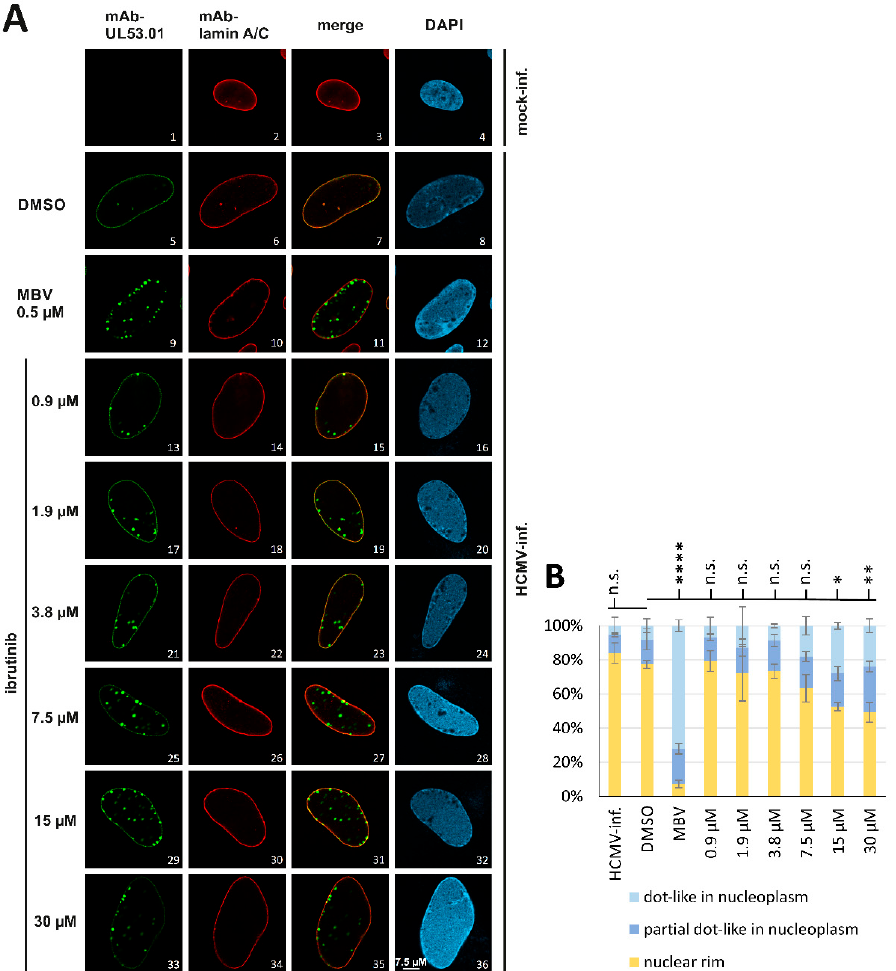
Figure 11. Inhibitory impact of hit compound ibrutinib on the localization of HCMV pUL53. ( A ) HFFs were infected with HCMV AD169 (MOI 0.1) and immediately treated with the warhead compound. Ibrutinib was applied at the indicated concentrations, and the determination was performed in biological triplicates. At 5 d p.i., cells were fi xed, used for IF staining with the indicated antibodies and analyzed for intranuclear localization by confocal imaging. DAPI counterstaining represented the nuclear morphologies of the respective cells. Additional single channel images in grayscale, allowing easier comparison of signal pa tt erns, are presented in Figure S5. For raw data, see h tt ps://doi.org/10.5281/zenodo.7794233 accessed on 3 April 2023. ( B ) Quantitation of this IF analysis was achieved by counting 50 cells per biological triplicate. Three pa tt erns of pUL53 localization were distinguished, i.e., normal nuclear rim (yellow), partial dot-like intranucleoplasmic aggregation (dark blue) and predominant dot-like aggregation (light blue). Mean values ± SDs are given. Statistical analysis was performed using ordinary one-way ANOVA and post hoc Tukey testing on combined dot-like pUL53 localization values of DMSO in relation to the analyzed ibrutinib concentrations and MBV; * p ≤ 0.05, ** p ≤ 0.01, **** p ≤ 0.0001; n.s., not signi fi cant.